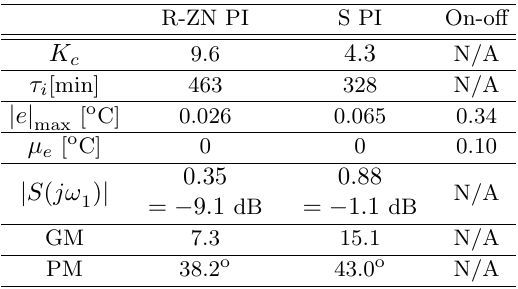
Table 5: Results with three different controllers. R-ZN PI = PI controller with R-ZN settings. S PI = PI tuned with Skogestad settings. On-off = On-off